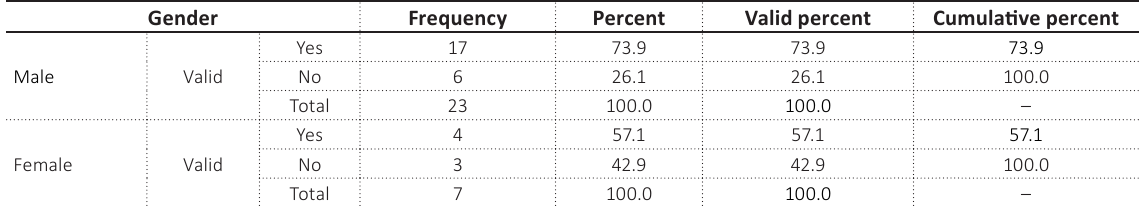
Table A4. Establishing eco villages or ethnic villages for tourists in Nainital